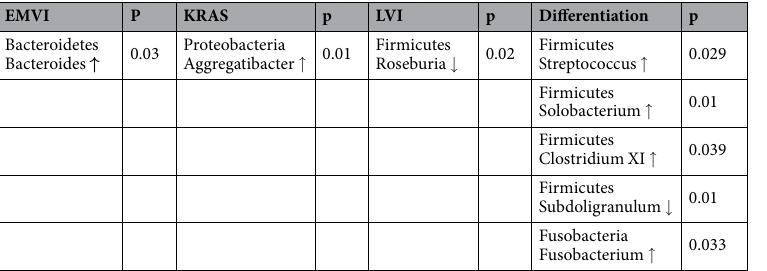
Table 2. Summary data of bacteria statistically over- or under-expressed in tumour samples and their statistical association with established histological biomarkers of poor prognosis. (EMVI = Extra mural vascular invasion, LVI = Lymphovascular